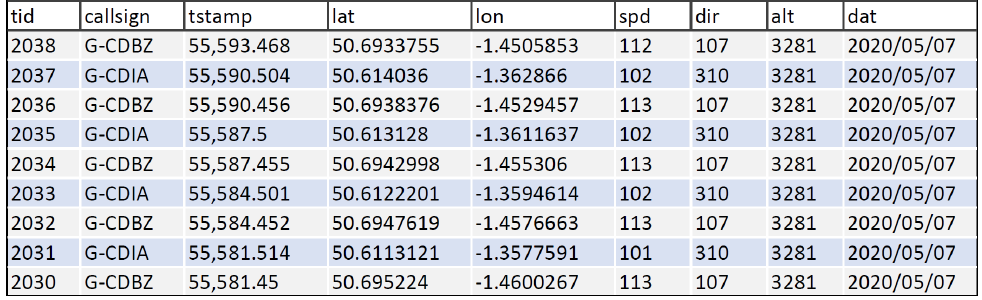
Figure 10. Partial view of the ‘Transmissions’ table.